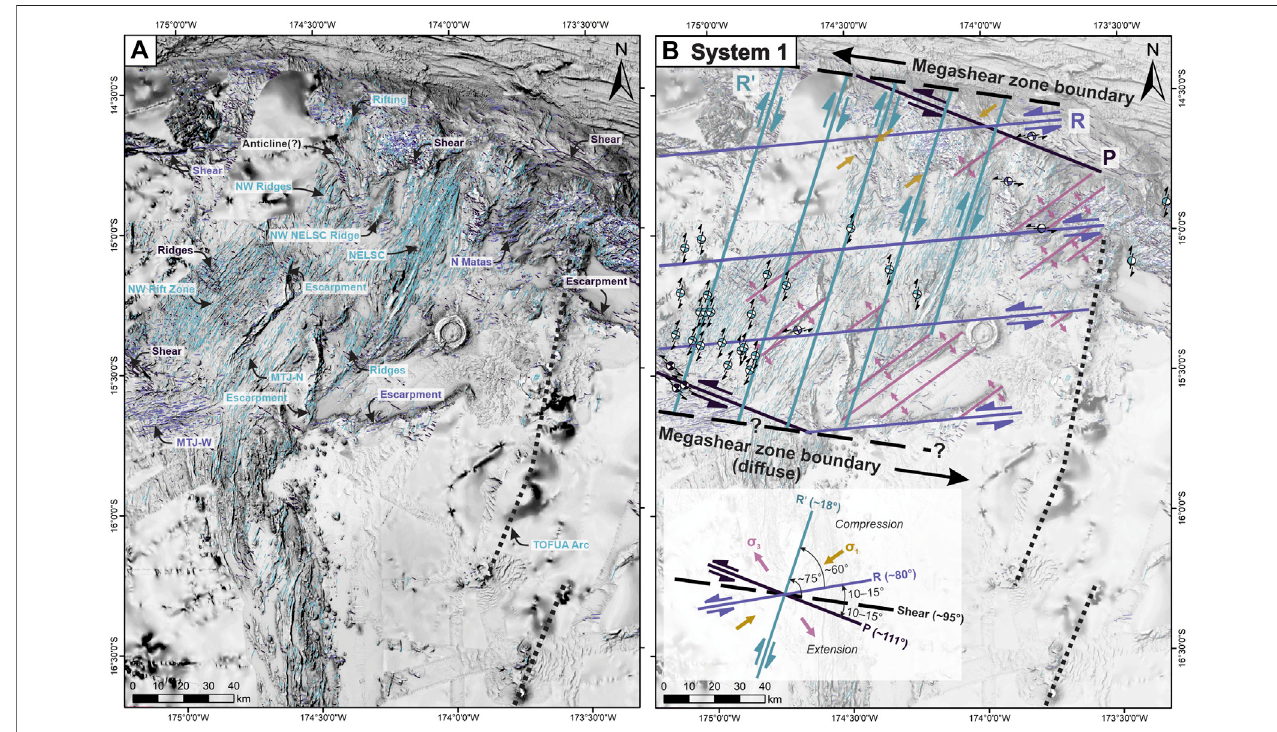
FIGURE 9 | The fi rst set of structures overlain on TTS-shaded bathymetry: (A) lineaments include NNE-trending ( ∼ 18 ° ), E-trending ( ∼ 80 ° ), and WNW-trending ( ∼ 111 ° ),andareassociatedwithnumerousmajorstructuralandvolcanicfeaturesinthemaparea(annotationsasin Figure2 ); (B) generalizedmegashearmechanismfor this set of structures (Riedels System 1), with shear zone boundaries oriented ∼ 98 ° , dominated by NNE-trending R ʹ -shears (R-lateral). Extension associated with σ 3 is offsetbyR-shears(L-lateral)andisalsoassociatedwithlargevolcanicridgesacrossthemap.Activeseismicity(CMTs)ismainlyrestrictedtothewesternmaparea, extending south to a diffuse boundary (dashed line). Bathymetric compilation as in Figure 3